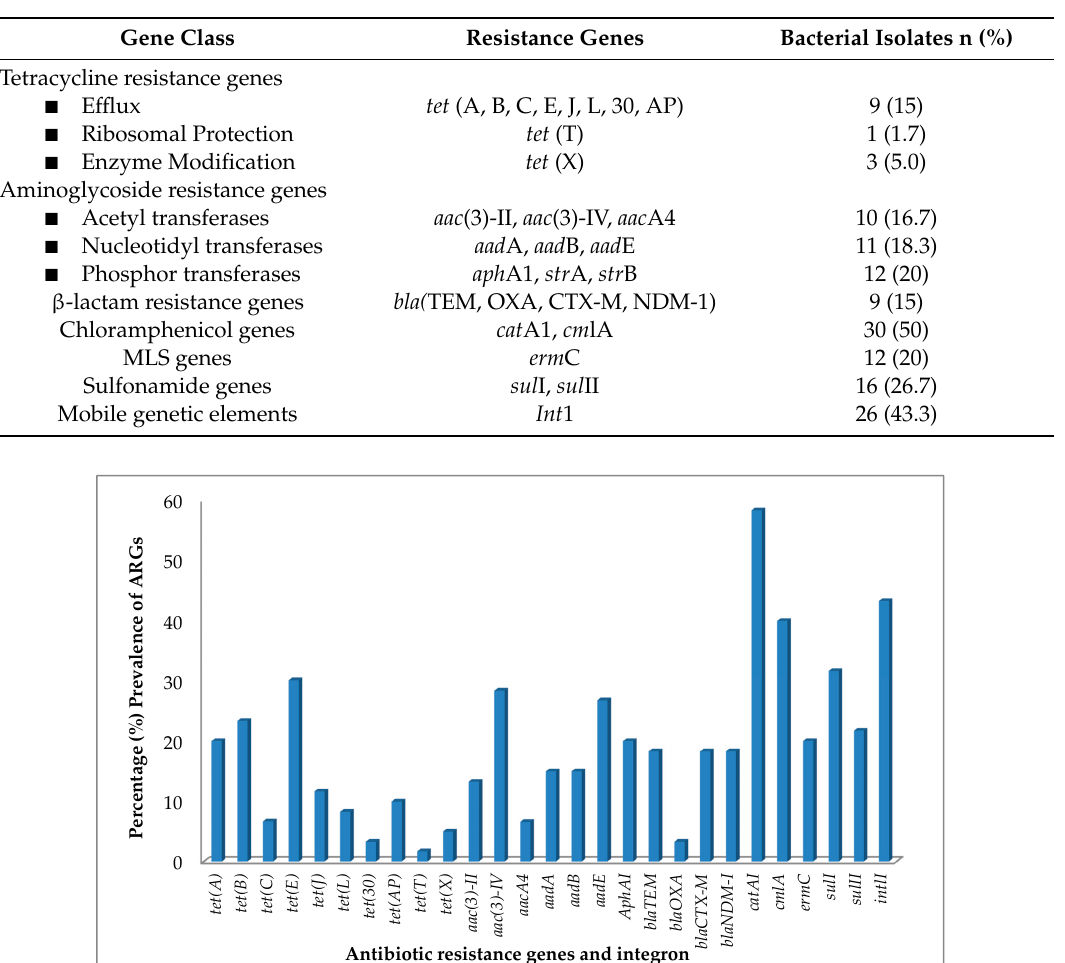
Table 2. Prevalence of antibiotic resistance genes and mobile genetic elements from bacterial isolates.